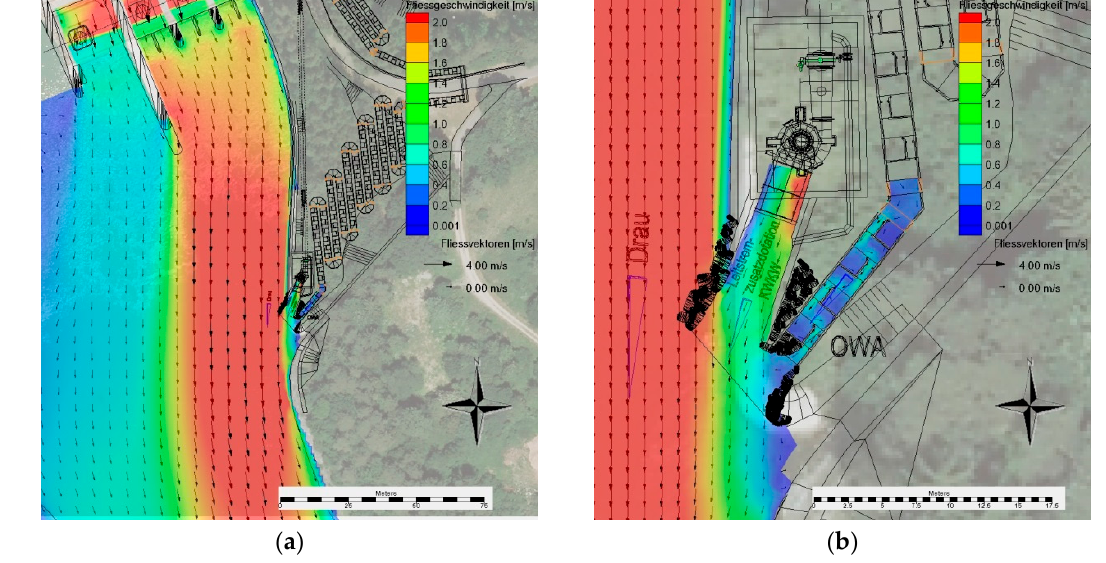
Figure 7. Alternative 2, result overview ( a ) and detail at entrance (b ) of the 2D model. Q Drava = 485 m 3 / s, Q fish pass = 0.38 m 3 / s + Q attraction flow = 4.47 m 3 / s; competing flow 1%.